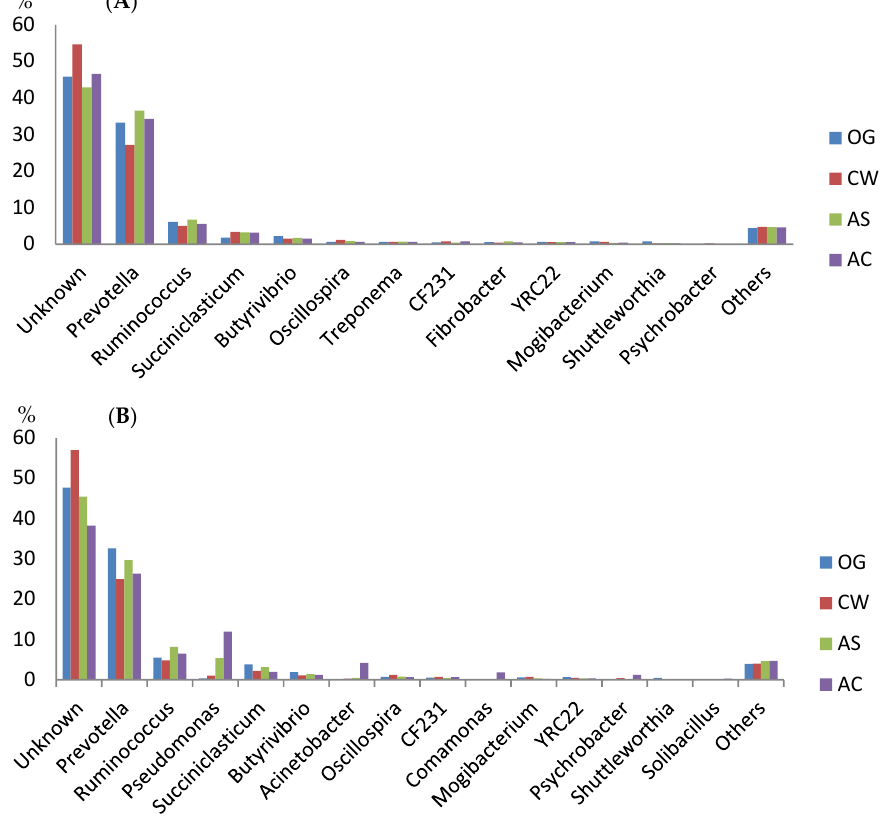
Figure 3. Taxonomy profile of rumen bacteria on genus level under different dietary treatments. (( A ) is 0 h, ( B ) is 3 h).